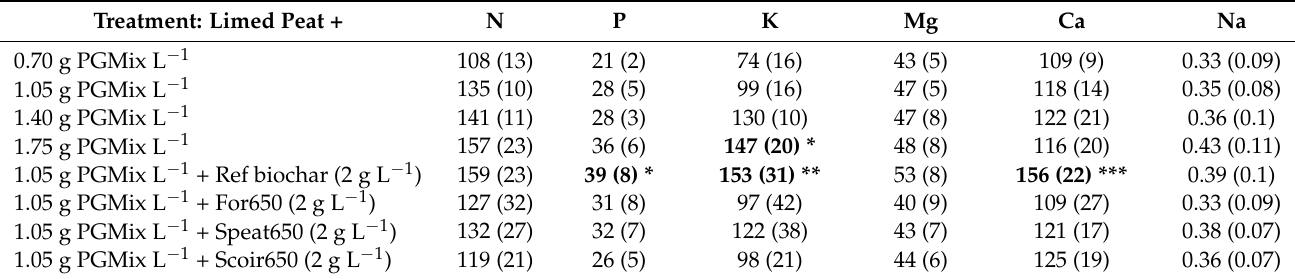
oak wood. PGMix: Multi-mix Potting Soil 14+16+18 mineral